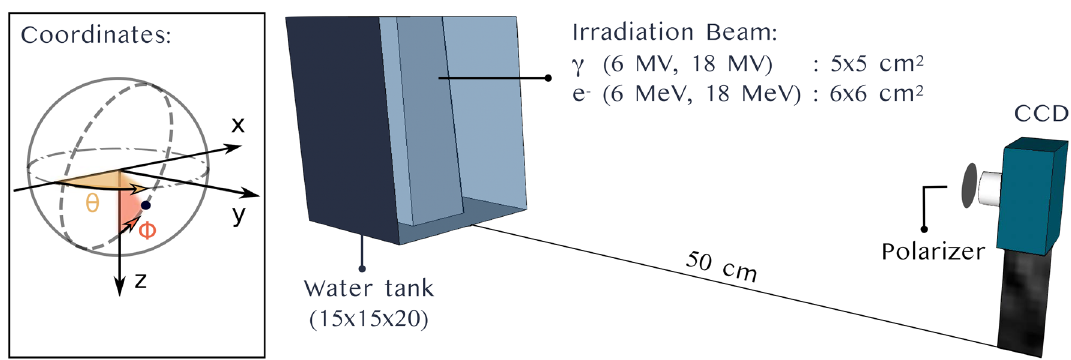
Figure 8. Representation of the measurement setup together with the irradiation conditions for PPDD and profile measurements. The setup image was created using SketchUp 35